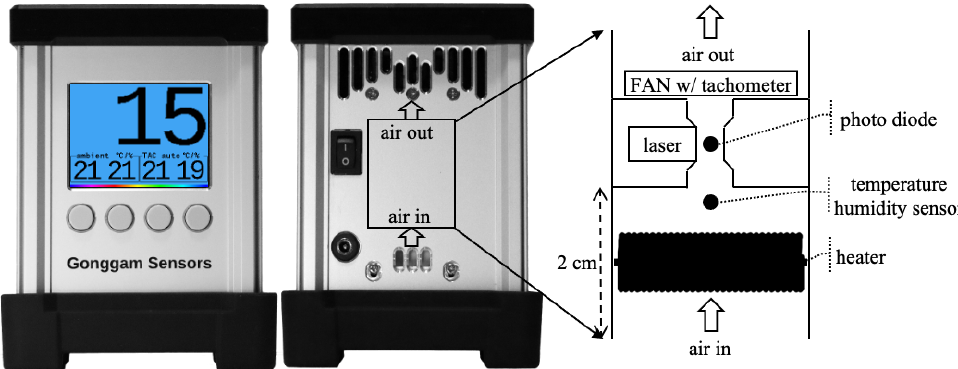
Figure 2. Back side of the proposed monitor and the internal structure of the tiny aerosol conditioner with the pneumatic flow (dehumidifier with upward